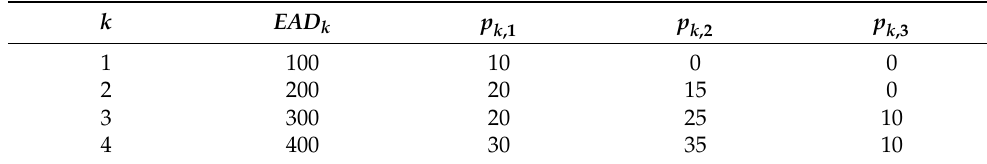
Table 1. Portfolio with K = 4 debt positions and 3 periods of delay.